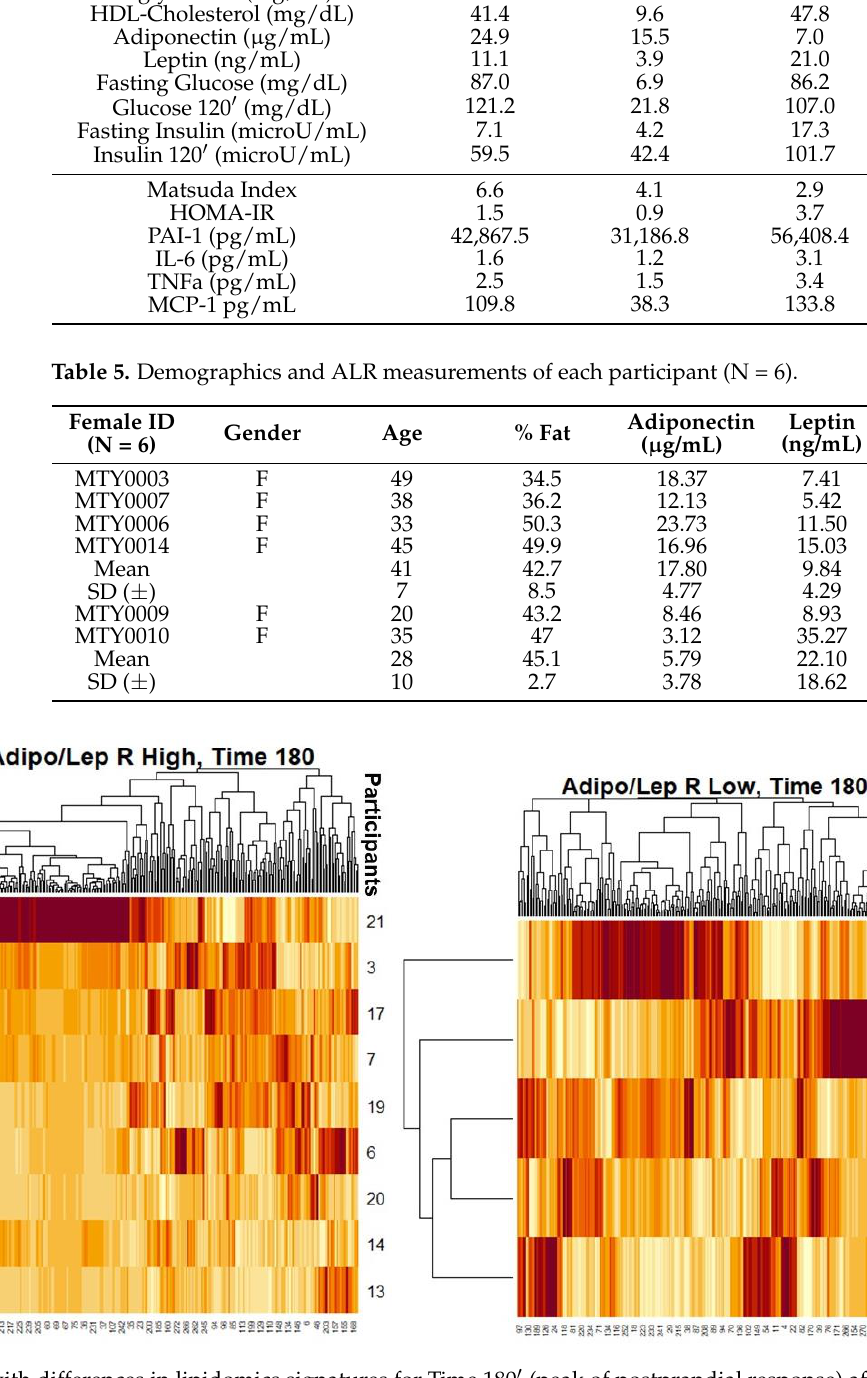
sion profiles are shown in Figures 2 – 5. The implications of these data are explained in the Section 4. Table 4. Demographics and clinical biochemistries in symptom-free adult volunteers (N = 14). Demographic Characteristics